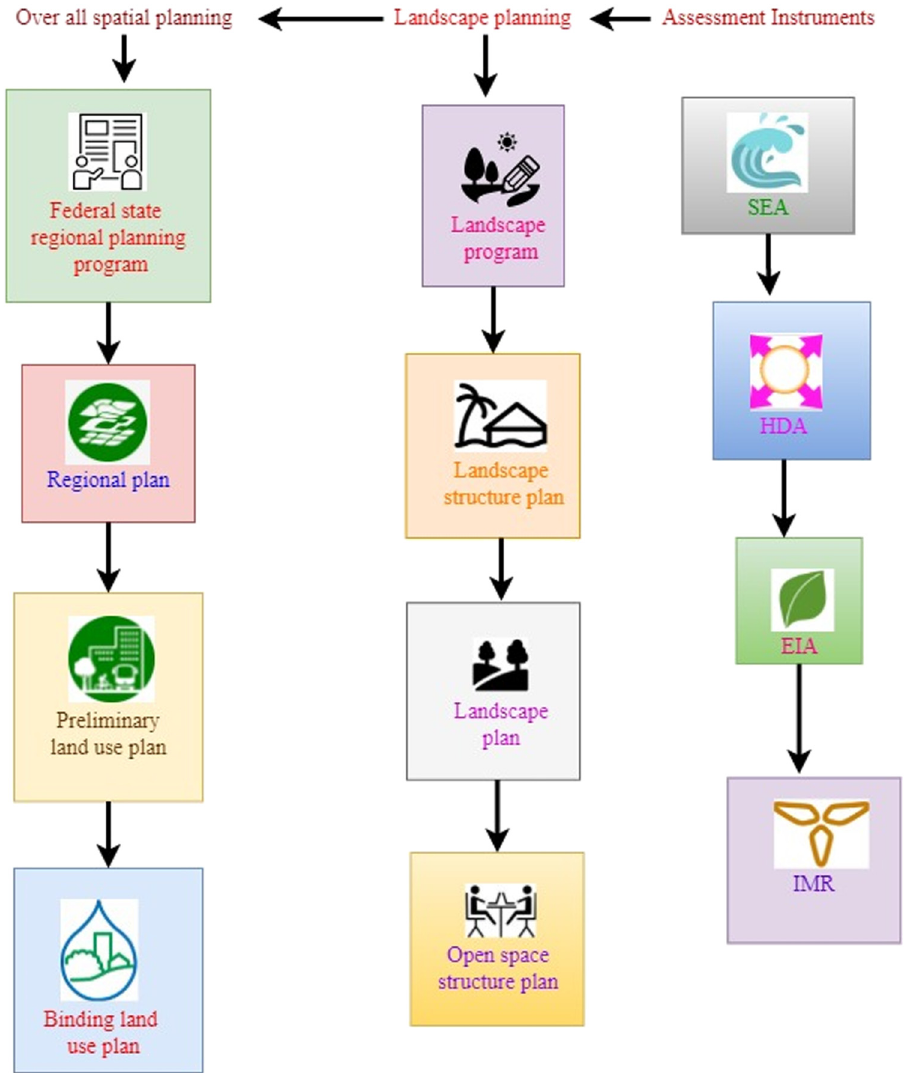
Figure 7: Environment of the landscape planning